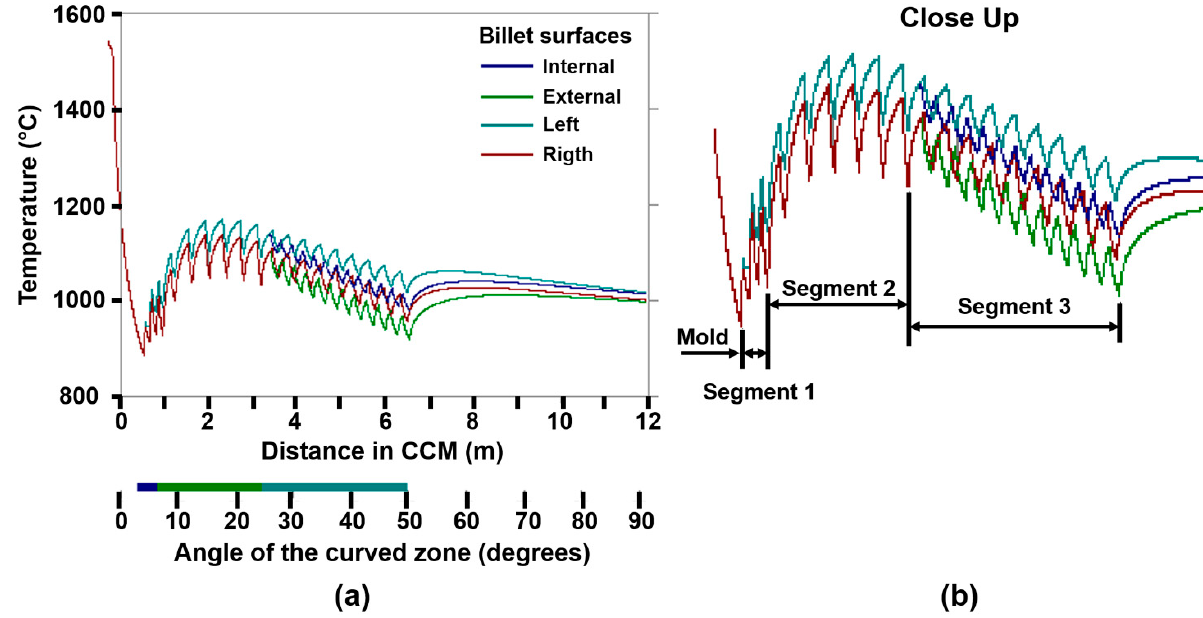
Figure 8. ( a , b ) Temperature on the billet surfaces due to the symmetrical heat removal applied (consequence of a non- symmetrical spray distribution and differential water flow rates).